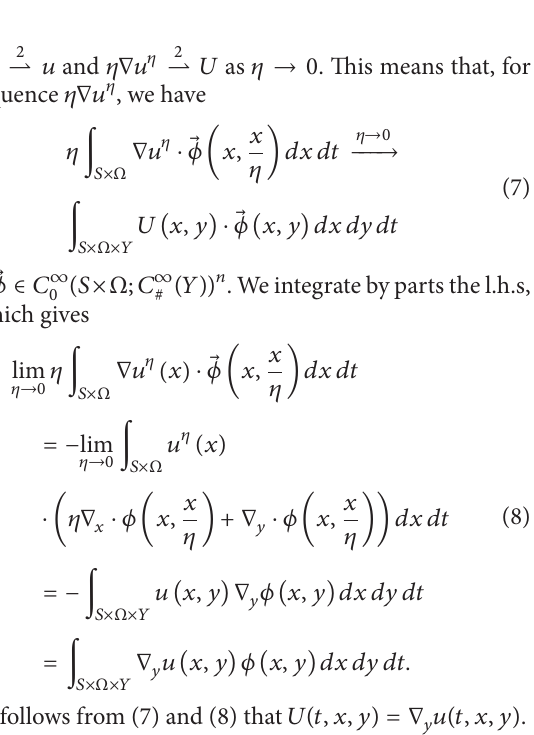
Figure 3: The metallic structure Σ 𝜂 inside the domain Ω